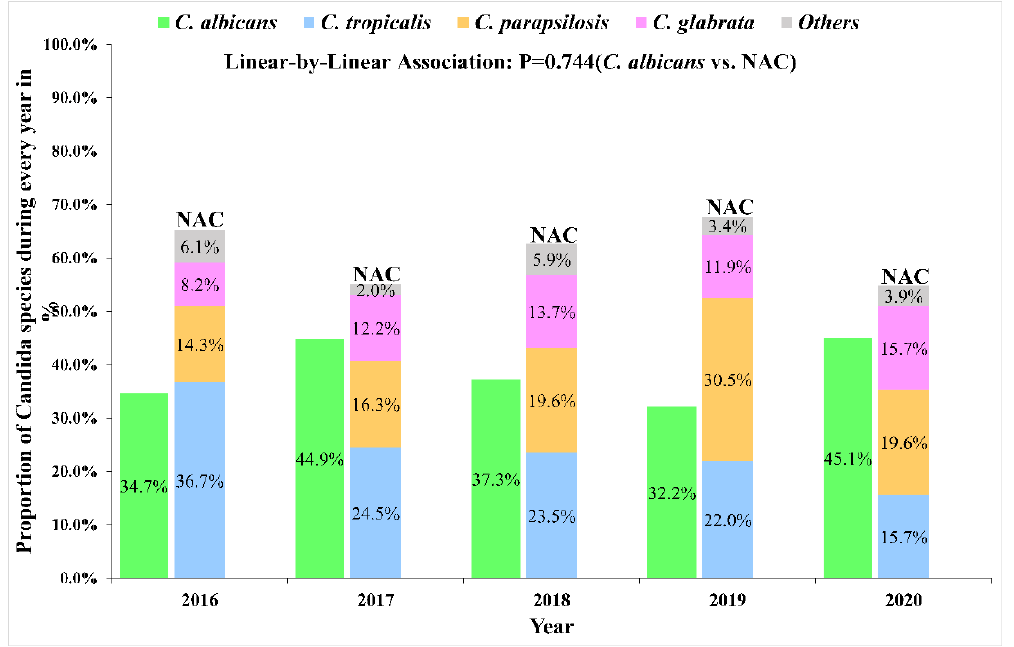
Figure 3. Change trend of C. albicans vs. non-albicans Candida over the five-year study period ( n =